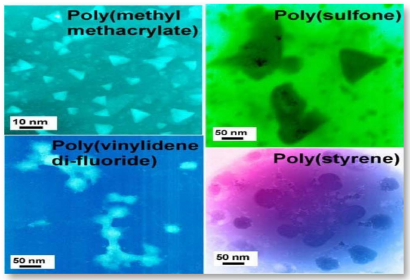
Figure 1. Functional nanocomposites for wastewater